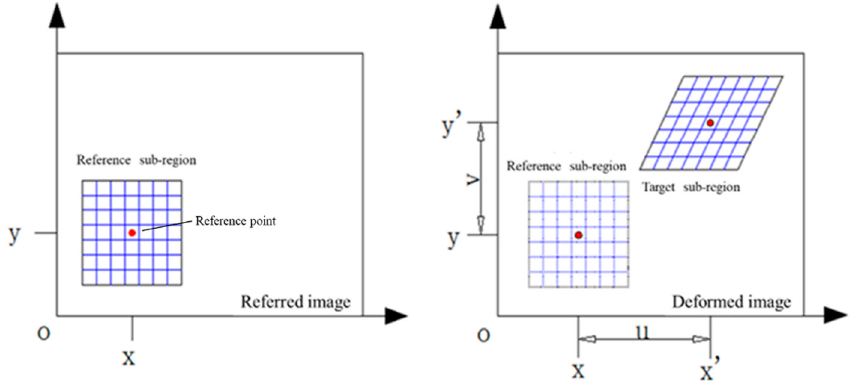
Figure 7. Displacement diagram before and after deformation.